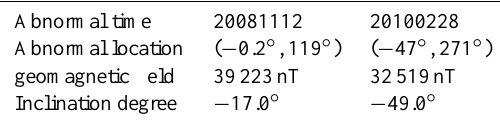
Table 1. Geomagnetic parameters at abnormal time and location before two